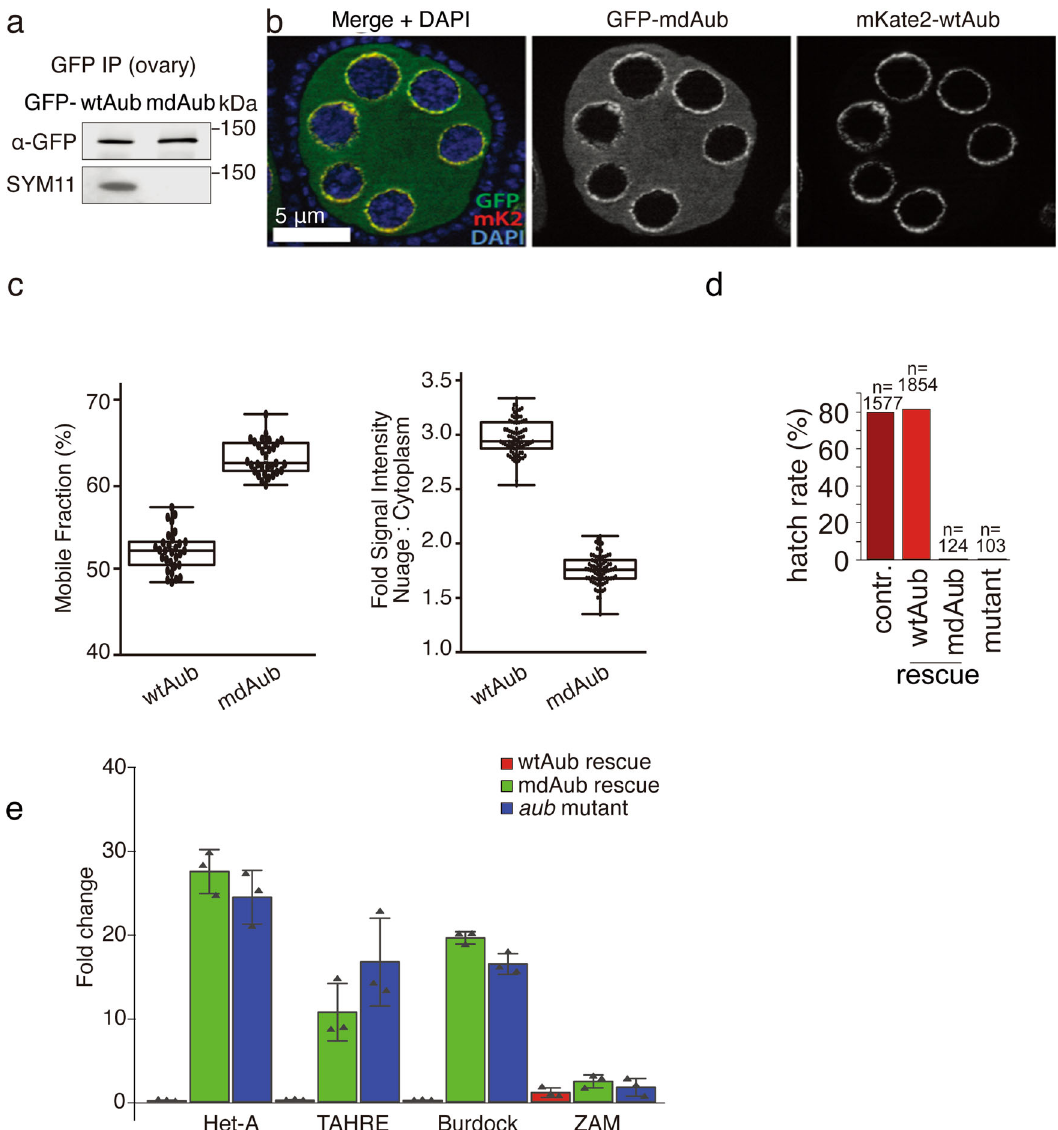
Fig. 3 Arginine methylation of Aub is required for fertility and TE repression. a Mutating conserved N-terminal Arginines to Lysines (mdAub) leads to loss of symmetric dimethylation of Aub. A similar amount of wtAub and mdAub was immunoprecipitated from ovaries. Methylation was detected by Western blot using the SYM11 antibody. Experiment reproduced twice with similar results. b In the wildtype background, mdAub colocalizes with wildtype Aub in nuage. GFP-mdAub and mKate2-wtAub were co-expressed in ovaries under the control of the endogenous Aub promoter. Scale bar: 5 μ m. Ten independent ovaries were used for imaging with similar results. c Arginine methylation de fi ciency slightly increases the fraction of mobile and dispersed cytoplasmic Aub protein. Left: the mobile fraction of nuage-localized GFP-wtAub and GFP-mdAub was determined in replicate FRAP experiments (constructs as in Extended Data Fig. 4c). (GFP-wtAub: n = 30 nurse cells. GFP-wtAub: n = 31 nurse cells). Experiments showed similar fractions of mobile proteins respectively. Right: microscopic quanti fi cation of the ratio of GFP signal originating from nuage versus cytoplasm is shown. (GFP-wtAub: n = 81 nurse cells. GFP-mdAub: n = 83 nurse cells). Experiments showed a similar ratio respectively. All transgenes are expressed under the control of the endogenous Aub promoter. Box plots present min to max, median, and all points. d Arginine methylation of Aub is required for fertility. The hatching rate of heterozygous control, Aub HN/QC mutant females, and mutant females rescued with wt- or mdAub transgenes are indicated as % of eggs laid. e Arginine methylation of Aub is required for TE suppression. Fold changes of different TE transcripts in ovaries of fl ies with the indicated genotypes compared to the heterozygous control as measured by RT-qPCR. n = 3 biologically independent experiments with similar results. Data are presented as mean values ±